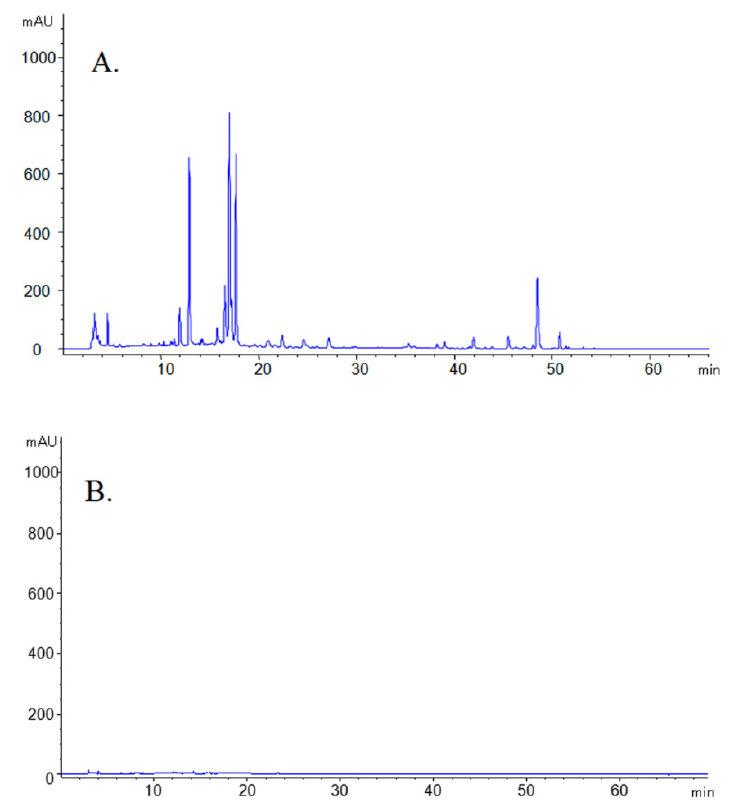
Figure 4. High performance liquid chromatogram of GRR ( A ) and GRR-CDs ( B ) aqueous solution.